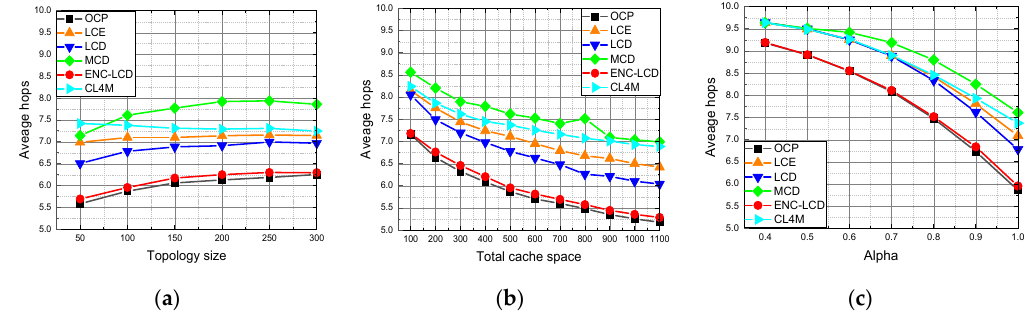
Figure 9. Performance of average hop count in content placement. (a)The average hop count under different topology sizes. (b)The average hop count under different total cache space. (c)The average hop count under different Zipf parameter Alpha.